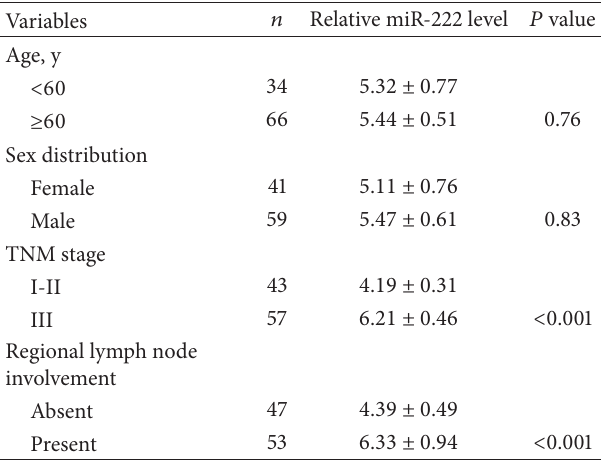
Table 1: Correlation between miR-222 expression and clinicopatho- logical characters in 100 non-small cell lung cancer patients.